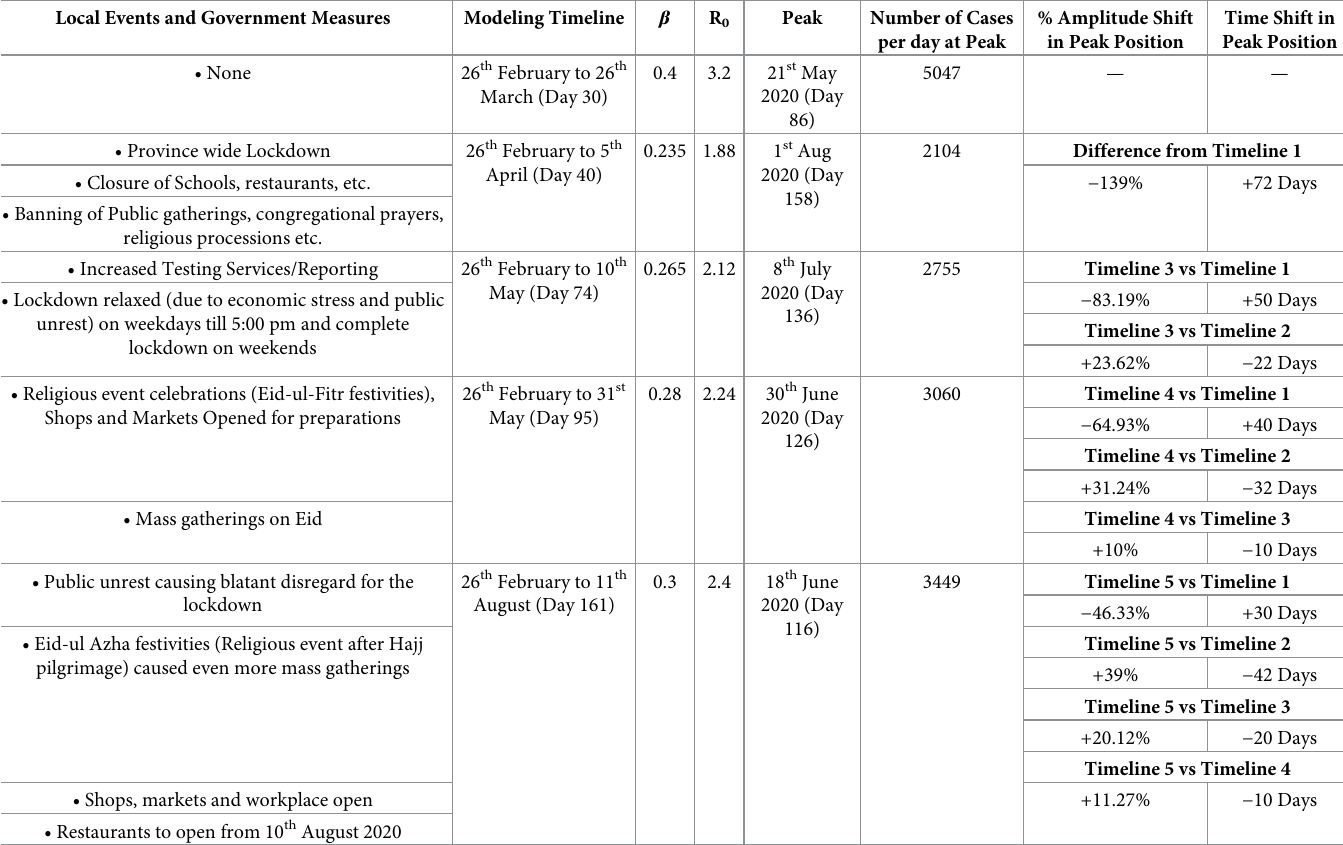
Table 2. A summary of the results obtained based on the governmental measures taken and its impact on the model through variation in the transmission rate β . Local Events and Government